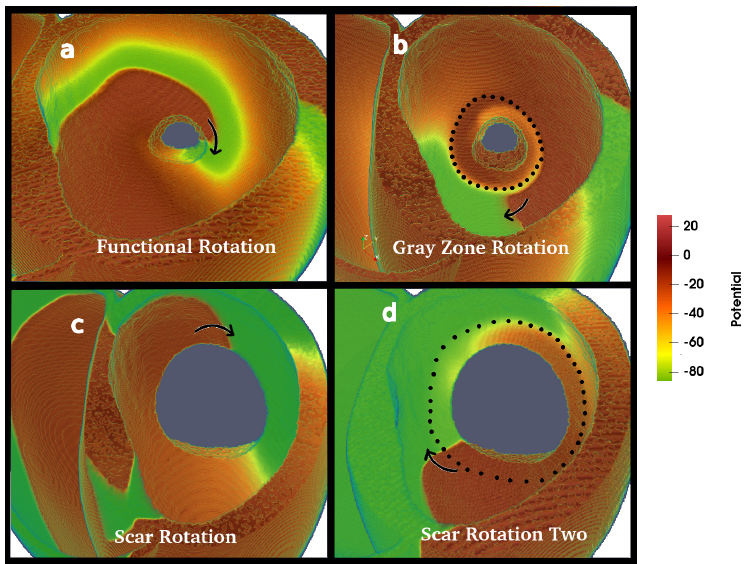
Figure 6. Examples of different rotation regimes (inside view of the left ventricle): ( a ) functional rotation , ( b ) gray zone rotation , ( c ) scar rotation , and ( d ) scar rotation two . Arrows indicate wave direction. Dots show the border of the gray zone. Gray color means the scar. The infarction perimeter for ( a , b ) is 35 mm, for ( c , d ) is 162 mm. The gray zone perimeter for ( a , d ) is 0 mm, for ( b , d ) is 7.5 mm. There are 398922 points on the images ( a , b ), and 366962 points on the images ( c , d ). Another important regime we found in the ventricular model is gray zone rotation